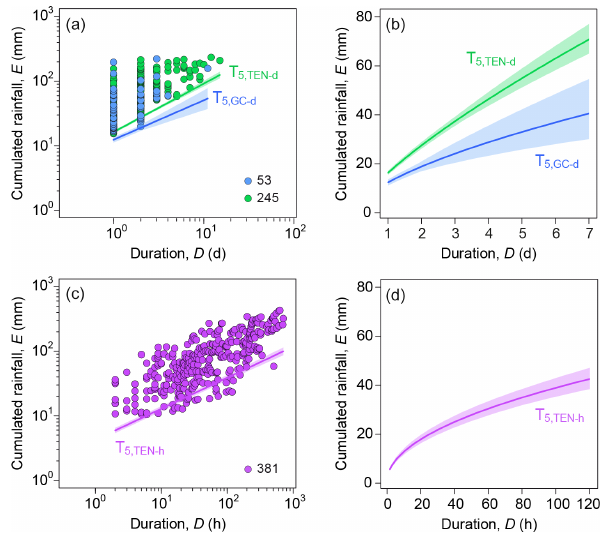
Figure 5. Rainfall thresholds for possible rockfall occurrence at the two test sites. (a) Rainfall duration D ( x axis, in days) and cumu- lated event rainfall E ( y axis, in millimeters) conditions that have produced rockfalls at the GC (53 blue dots) and TEN (245 green dots) test sites, respectively. Green and blue curves are the 5% power law thresholds ( T 5 , TEN-d , T 5 , GC-d ). (b) 5% daily ED thresh- olds for GC and TEN, in linear coordinates, in the duration range of 1 ≤ D ≤ 7d. (c) Rainfall duration D ( x axis, in hours) and cumu- lated event rainfall E ( y axis, in millimeters) conditions that have produced rockfalls at the TEN (381 purple dots) test site. The pur- ple curve is the 5% power law threshold ( T 5 , TEN-h ). (d) 5% hourly ED thresholds for GC and TEN, in linear coordinates, in the dura- tion range of 1 ≤ D ≤